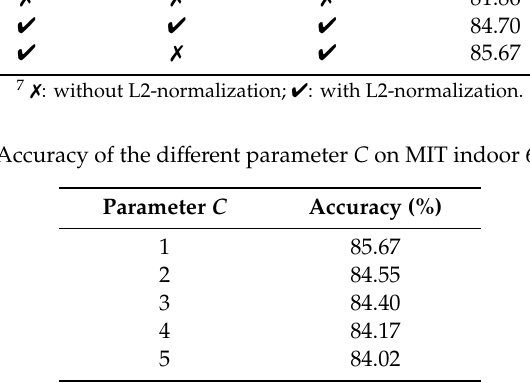
Table 7. Accuracy with L2-normalization or without L2-normalization on MIT Indoor 67 dataset. V GR